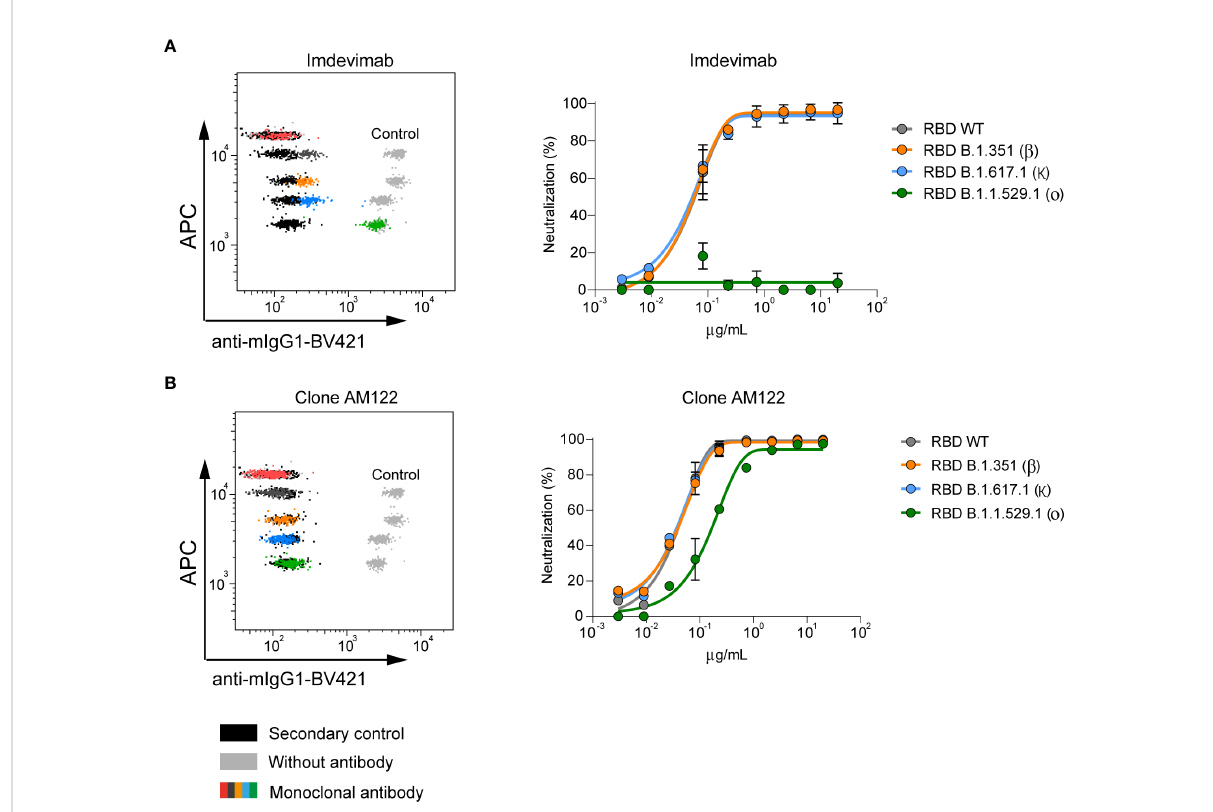
FIGURE 2 Neutralizing capacity of anti-RBD monoclonal antibodies measured by nC19BA. (A) A representative fl ow cytometry dot plot showing the neutralizing capacity of Imdevimab (25) against the indicated variants ( left ) and a dose-response curve starting at 20 µg/mL ( right ). (B) Representative fl ow cytometry dot plot and dose-response curve of anti-RBD monoclonal antibody, clone AM122